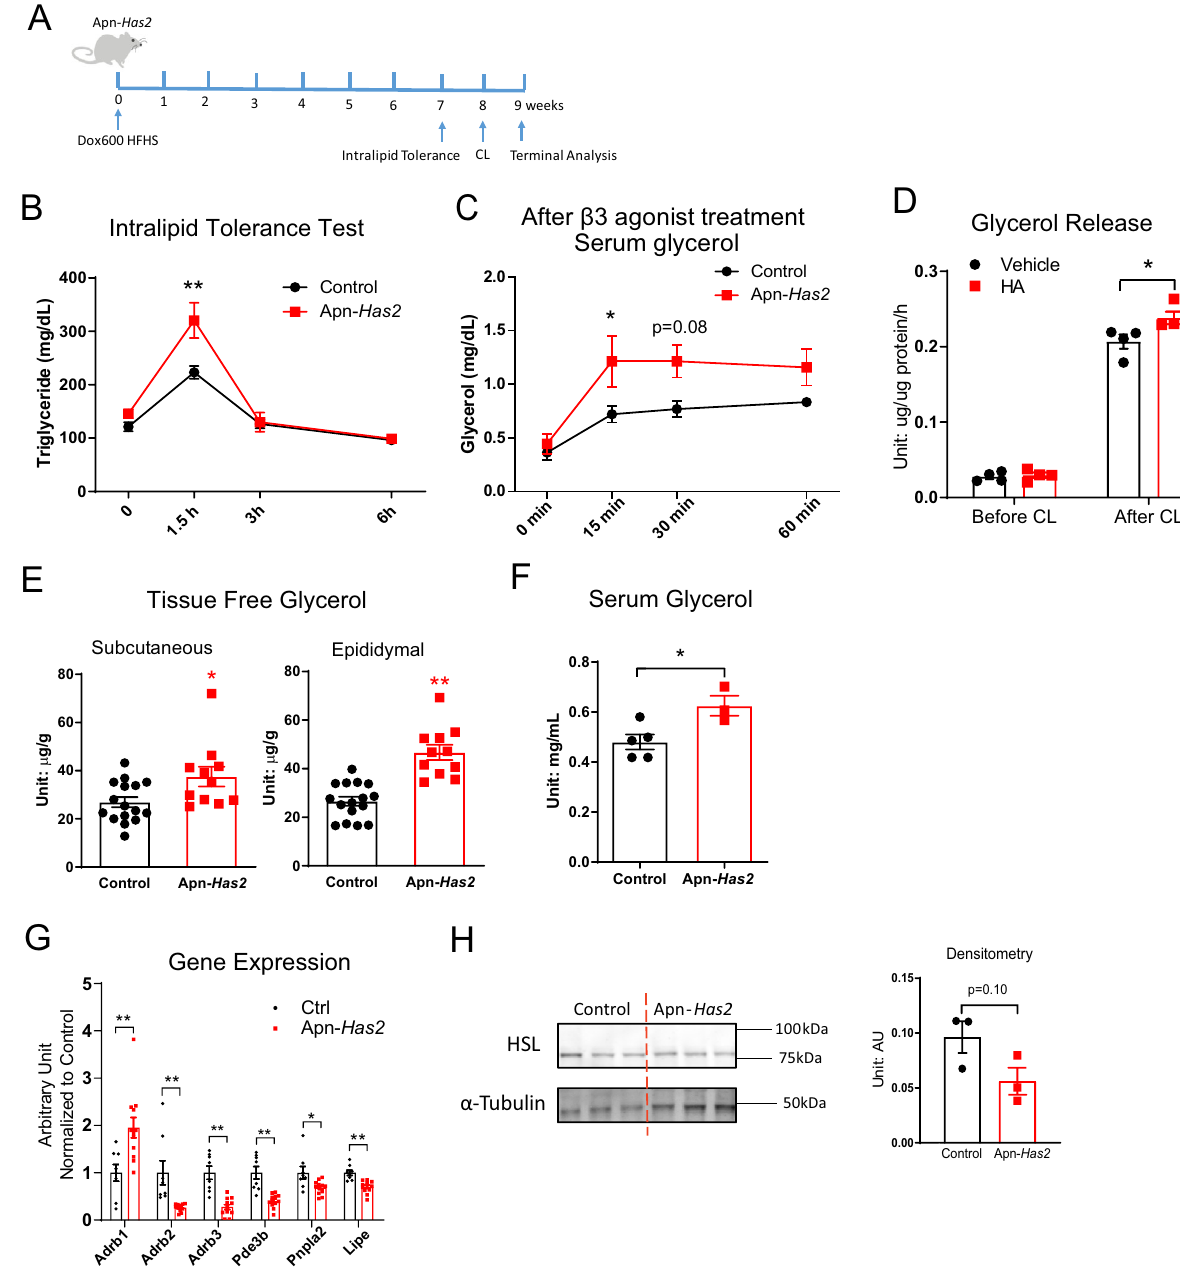
Fig. 7 Cellular Has2 overexpression primes cells for lipolysis. A Schematic representation of Apn- Has2 mouse treatment for panels B – H . Multiple cohorts of mice were used; CL: CL 316,243. B Intralipid tolerance test for Apn- Has2 mice ( n = 6 mice per genotype). Two-way ANOVA followed by Sidak ’ s multiple comparisons test, adjusted p -value = 0.7001, 0.0002, 0.9997, 1 for 0, 1.5, 3, and 6 h, respectively. C Glycerol release after β 3 adrenergic receptor agonist CL 316,243 treatment ( n = 5 mice per group). Two-way ANOVA followed by Sidak ’ s multiple comparisons test, adjusted p -value = 0.9869, 0.0439, 0.0813, 0.3049 for 0, 15, 30, and 60 min, respectively. D Glycerol release from in vitro differentiated adipocytes treated with HMW HA (10 µ g/mL, 5 h) before and with CL 316,243 (1 µ M) stimulation for 2 h ( n = 4 mice per group). Two-way ANOVA followed by Sidak ’ s multiple comparisons test, adjusted p - value = 0.9749, 0.0125 for Vehicle vs. HA treatment before CL and after CL, respectively. E Tissue glycerol levels in Apn- Has2 mice ( n = 16 mice for control, n = 11 mice for Apn- Has2 ). Two-tailed t -test, p = 0.0187, <0.0001 for Subcutaneous and Epididymal depot, respectively. F Serum glycerol of Apn- Has2 mice after overnight fasting ( n = 5 mice for control, n = 3 mice for Apn- Has2 ). Two-tailed t -test, p = 0.0266. G Expression of lipolysis related genes in inguinal adipose tissue from mice treated with 5 days of Dox600 chow diet ( n = 8 mice for control, n = 12 mice for Apn- Has2 ). Multiple two-tailed t -test, p = 0.0053, 0.0024, 0.00003, 0.00008, 0.014, 0.002 for Adrb1, Adrb2, Adrb3, Pde3b, Pnpla2, Lipe , respectively. H Western blot of HSL protein. Tissue lysates were prepared from the white adipose tissue dissected from mice treated with 9 weeks of Dox600 HFHS diet. HSL and Tubulin were blotted on two membranes in parallel. Densitometry result of HSL signal normalized to α -Tubulin is shown on the right ( n = 3 mice per genotype). Two-tailed t -test, p = 0.10. All data are presented as mean ± s.e.m. *indicates p ≤ 0.05, **indicates p ≤